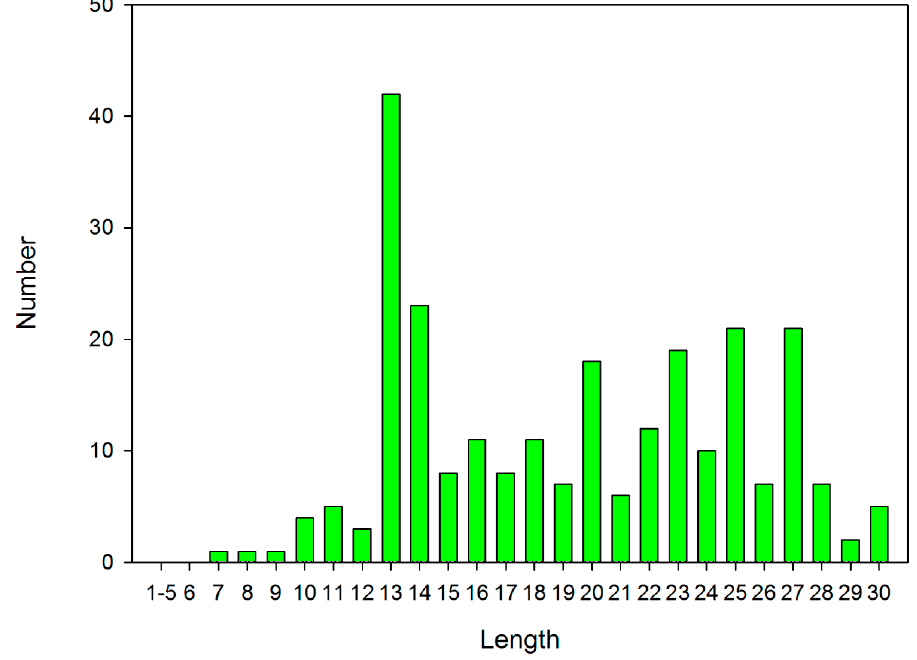
Figure 1. Distribution of length of ribosomal peptides active against Escherichia coli ATCC 25922 .